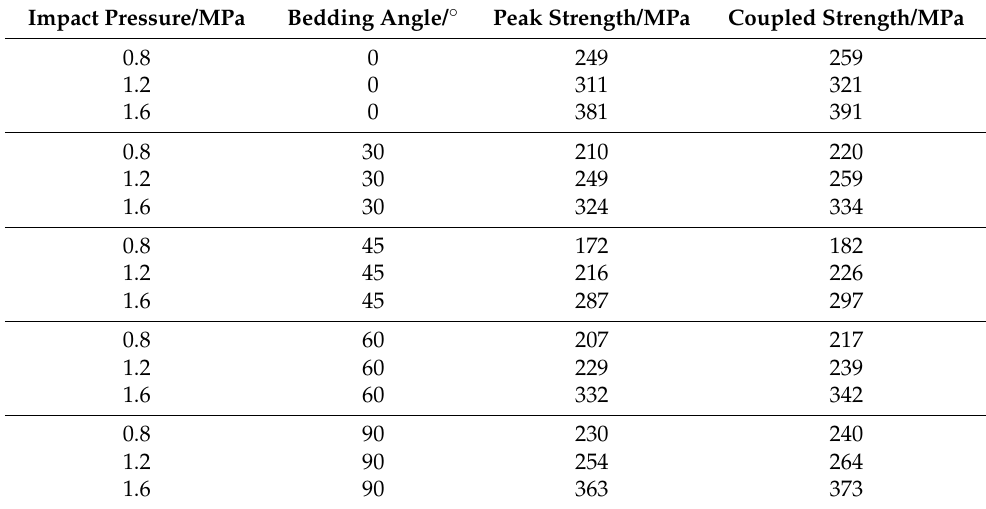
Figure 7. Coupled strength of sandstone under different loading conditions. ( a ) Two-dimensional cloud map of coupled strength. ( b ) Three-dimensional map of coupled strength. ( c ) Different bedding angles. ( d ) Different impact pressure. Table 1. Peak strength and coupling strength of